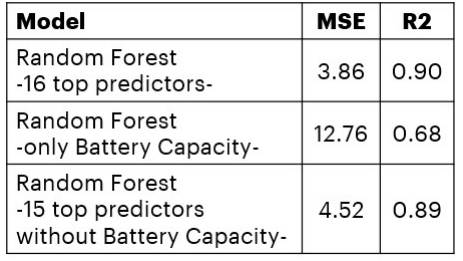
Figure 18. Model training with different combination of top